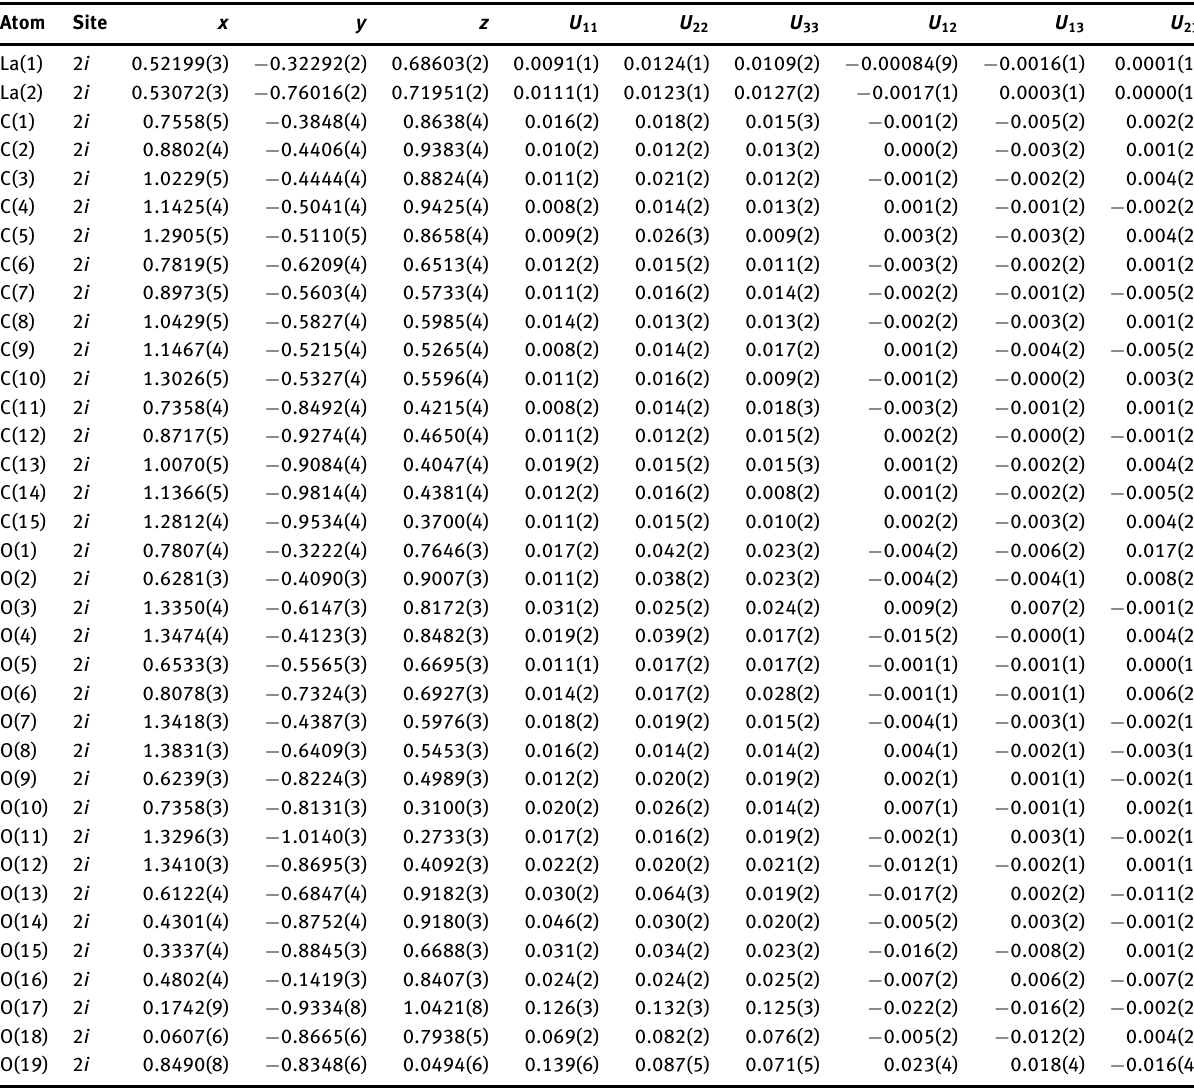
Table 3: Atomic displacement parameters (Å 2